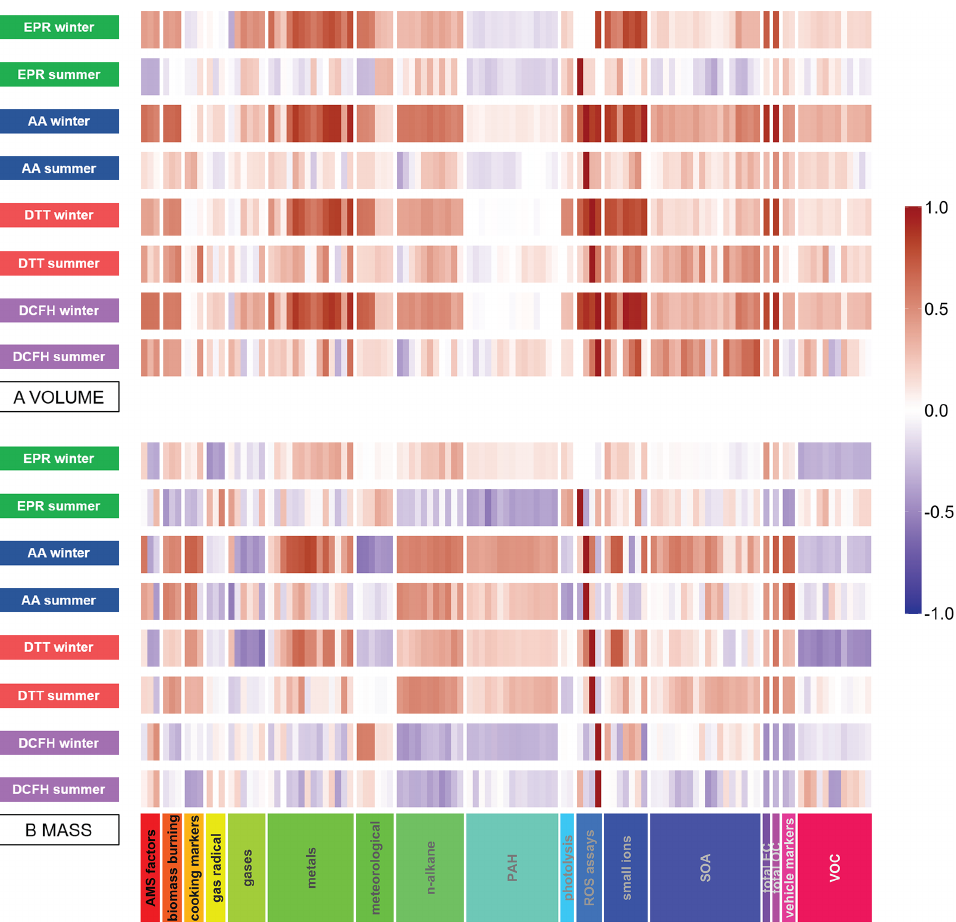
Figure 5. Heat maps demonstrating the correlation of OP, expressed as volume-normalised OP v (a) and mass-normalised OP m (b) vs. a range of additional measurements conducted during the APHH campaign. Red indicates positive correlation; blue indicates inverse correlation. For OP m , particle-phase components are also mass-normalised (µg per µg PM 2 . 5 ), and for OP v the components are volume-normalised (µg or ng per m 3